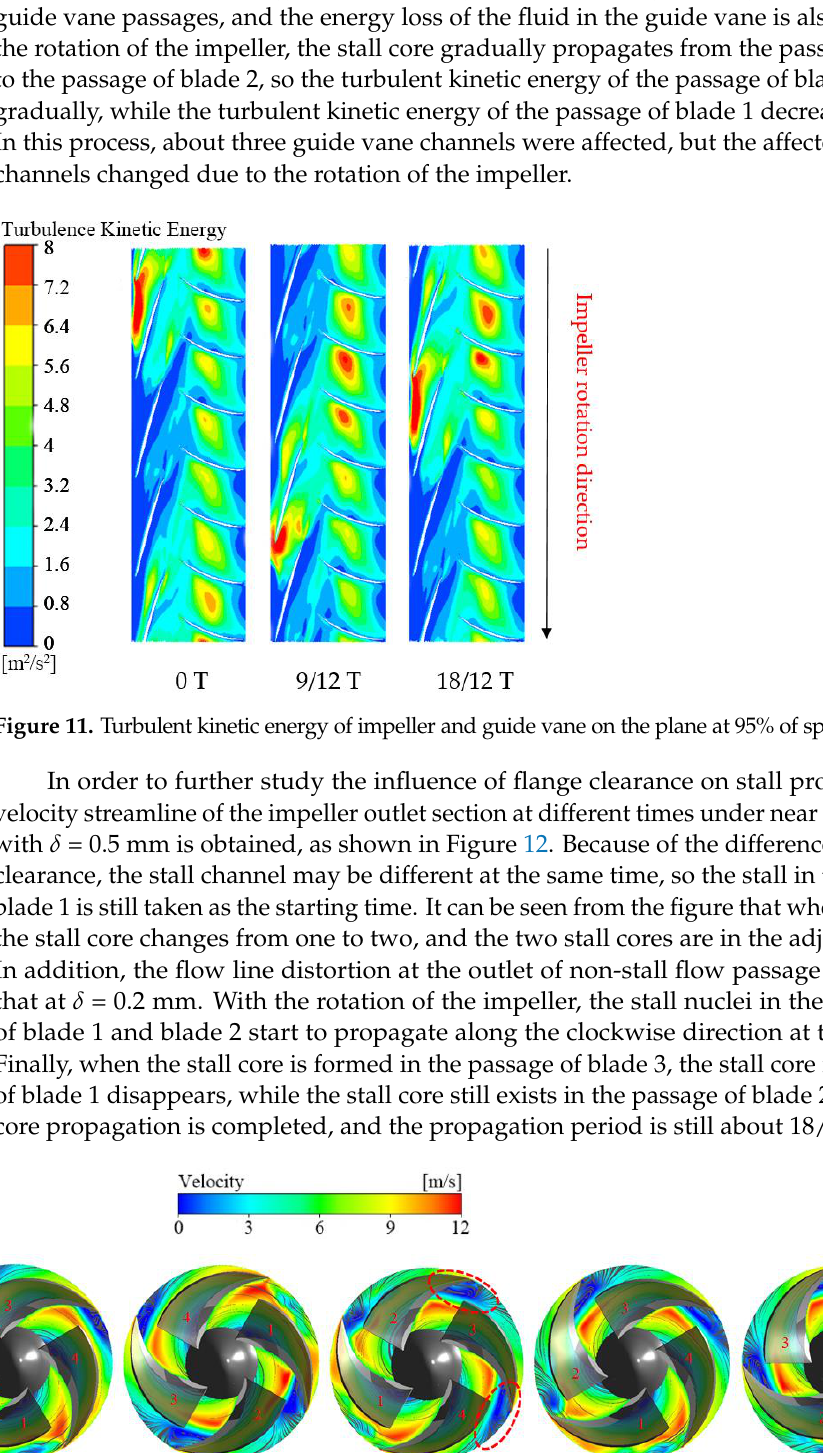
Figure 10. Velocity vector of impeller on the plane at 95% of span ( δ = 0.2 mm).